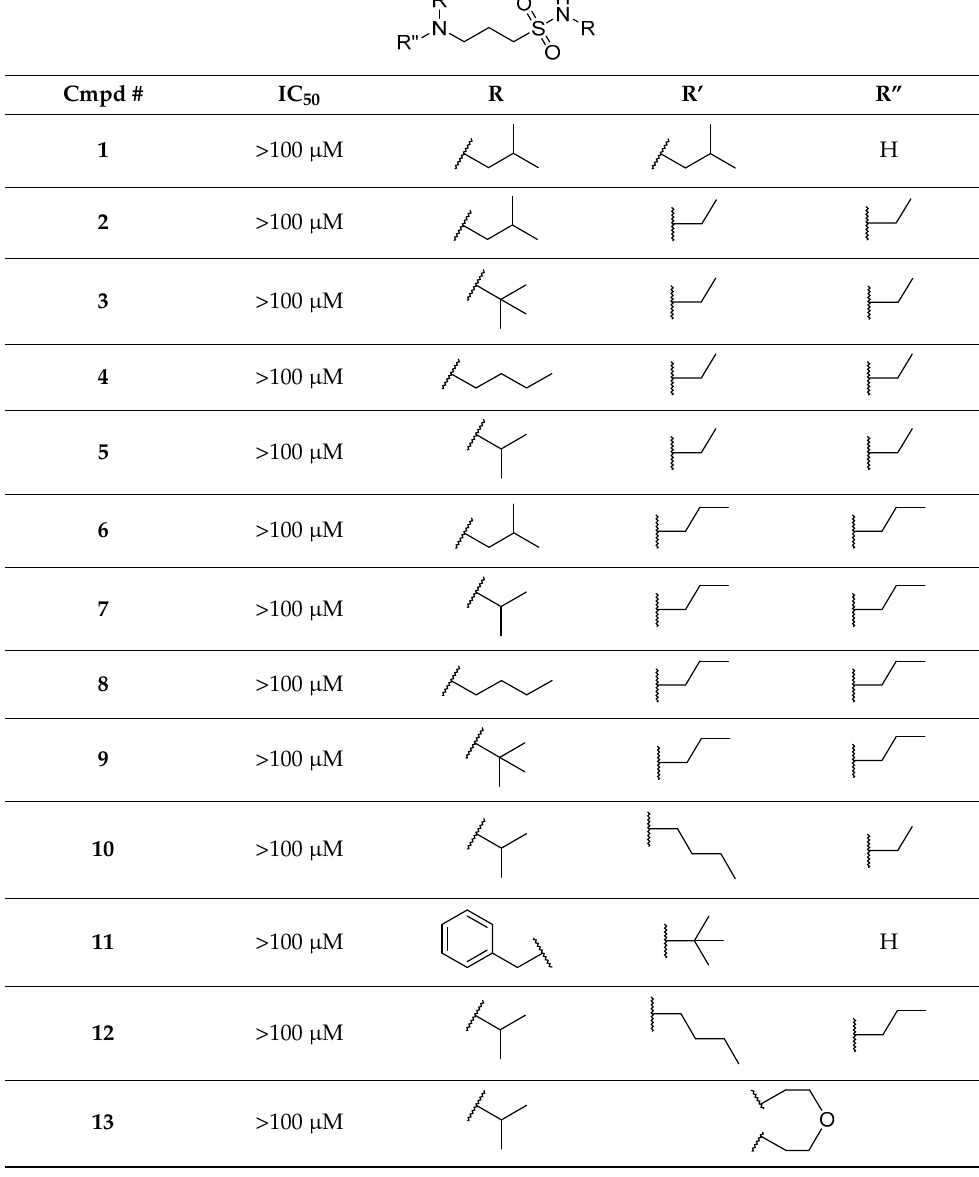
Figure 2. ThT fluorescence assay. Select sulfonamide derivatives ( 2 , 3 , 7 ) at 100 μ M with Phenol red (100 μ M) as a positive control. Fluorescence was recorded every 5 min for 120 min. Table 1. Library and IC 50 values of homotaurine